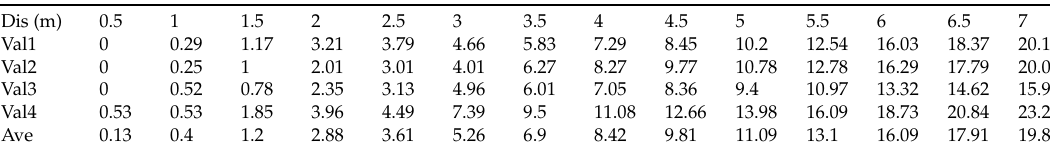
Table 3. Precision while using a single size of 3D-window.